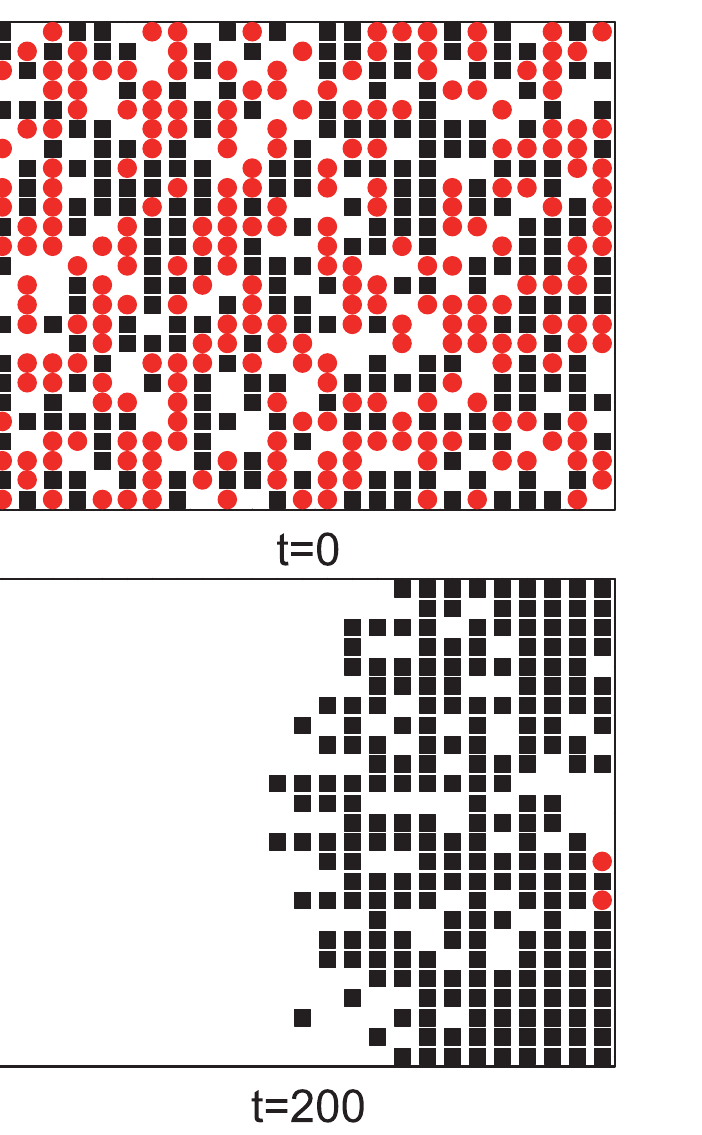
Fig 3. Typical pattern of evolution of pedestrians on square lattice 25 × 25. The pedestrians with motion mode I are indicated by black squares, and the pedestrians with motion mode II are indicated by red circles. Here, ρ II = 0.5.